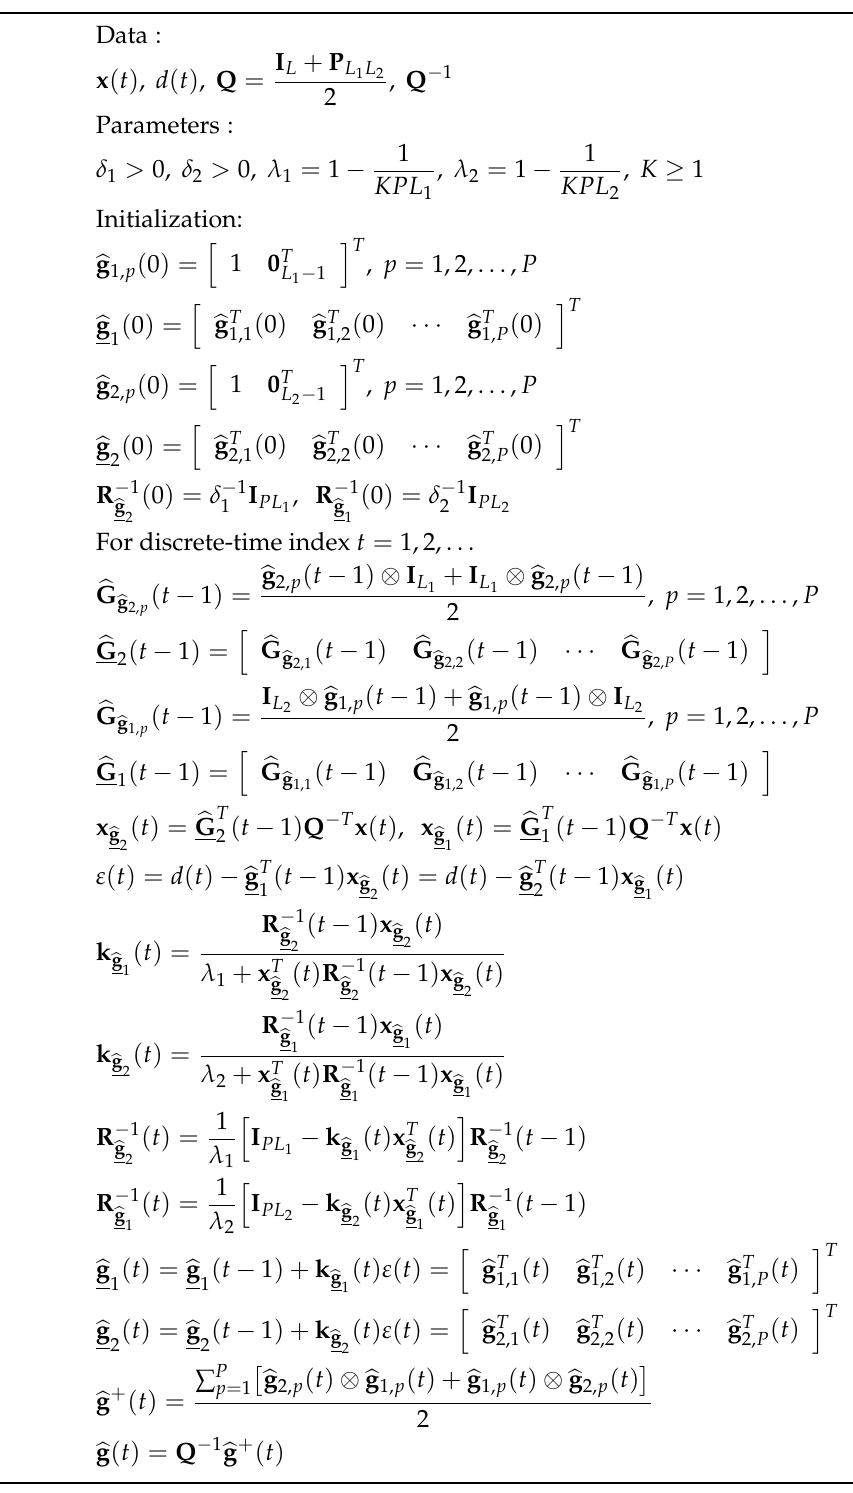
Table 1. RLS algorithm with symmetric filter